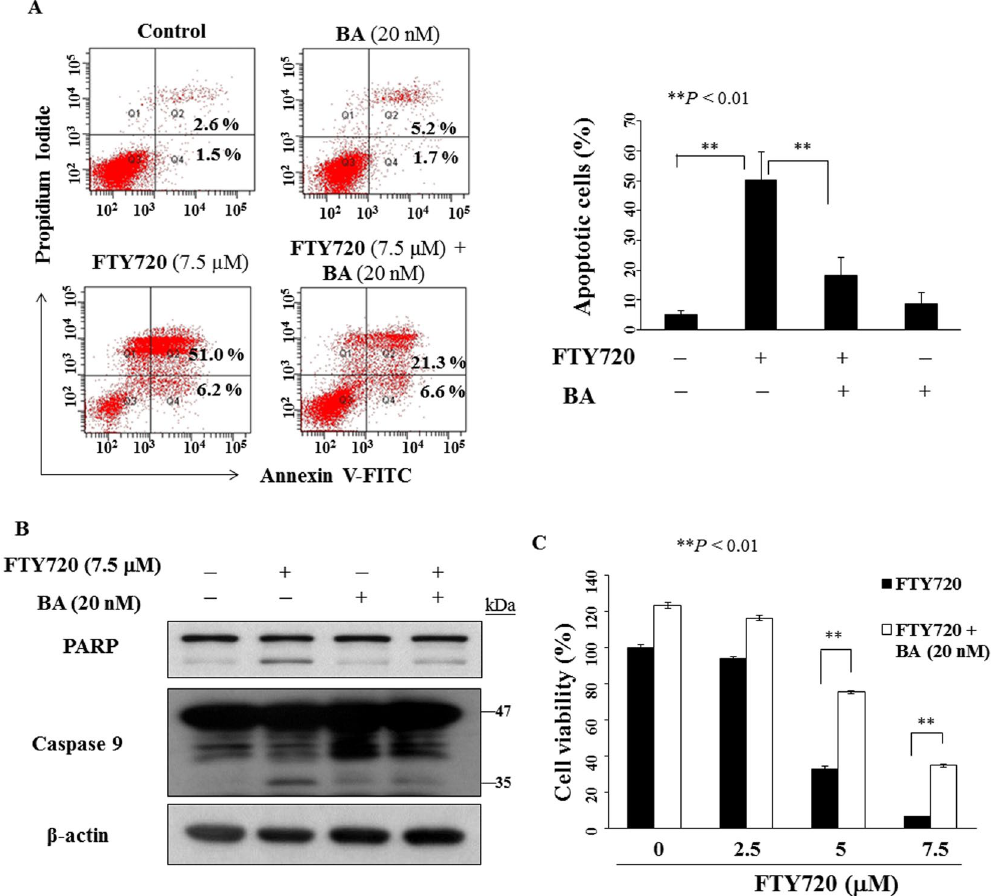
Figure 4. Effects of the autophagic inhibitor on FTY720-induced apoptosis. ( A ) Left, SCC2095 cells were treated with 7.5 μ M FTY720 alone or in combination with 20 nM bafilomycin A1 (BA) for 24 h, and then Annexin V-FITC/PI double-staining analysis was performed. Right, percentages in the graphs represent the percent of cells in the respective quadrants. Columns , means; bar , S.D. ** P < 0.01. ( B ) Effects of 7.5 μ M FTY720 or 20 nM BA or the drug combination relative to DMSO control in SCC2095 cells after 24 h. ( C ) FTY720- inhibited cell growth could be blocked by BA. Cells were treated with FTY720 at indicated concentrations in the presence of 20 nM BA or DMSO for 24 h, and cell viability was determined by MTT assays. Points , means; bar , S.D. (n = 6). ** P <